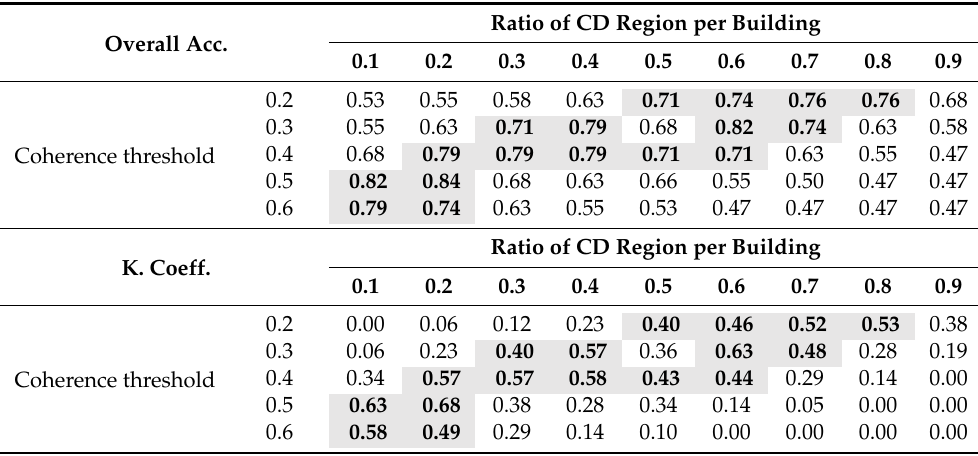
Table 3. Overall accuracy and Cohen’s Kappa coefficient for coherence analysis with buildings over 200 m 2 and with DL 2 or greater. Bold numbers with gray background represent the cells which accuracy and K-coefficient are over 0.7 and 0.4 respectively.